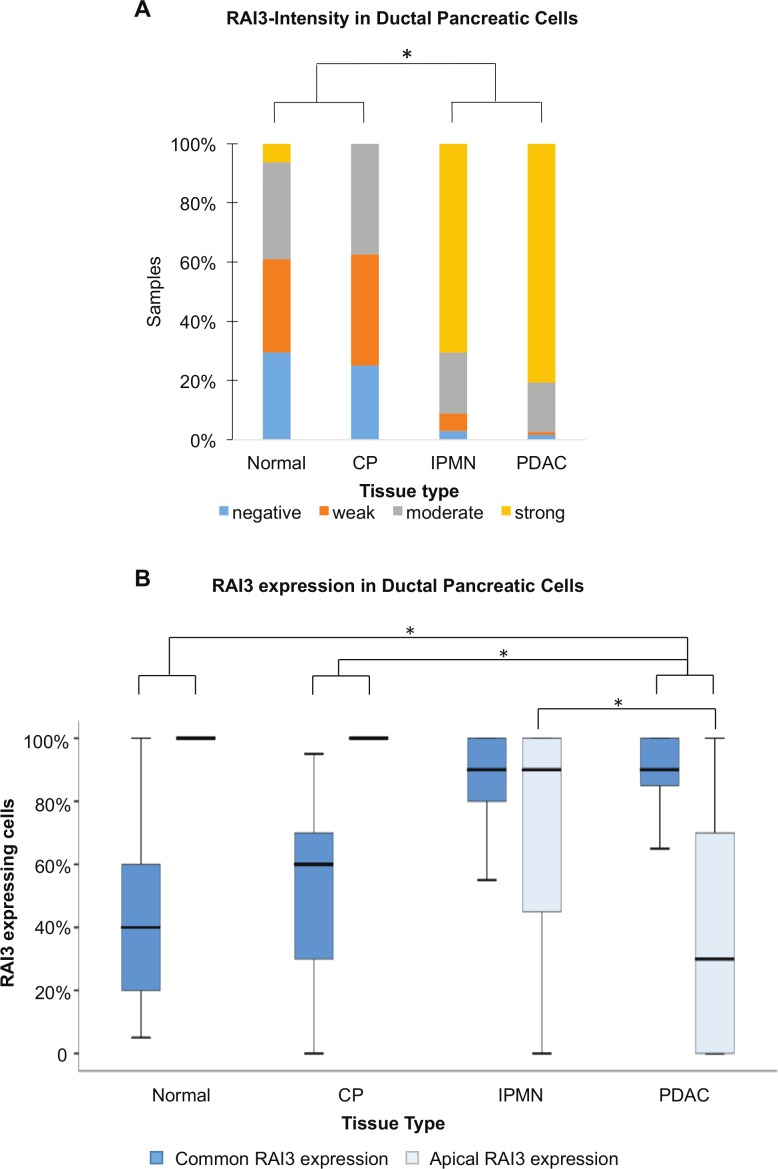
Intensity and Expression of RAI3 in Ductal Pancreatic Cells of different tissue types.A: Relative distribution of RAI3-Intensity (* indicates statistically significant differences (p < 0.001) according to Fisher‘s exact test); B: Comparison of the parameters Common Rai3-Expression and Apical Rai3-Expression (* indicates statistically significant differences (p < 0.001) according to Mann-Whitney-Test with Bonferroni-adjustment).